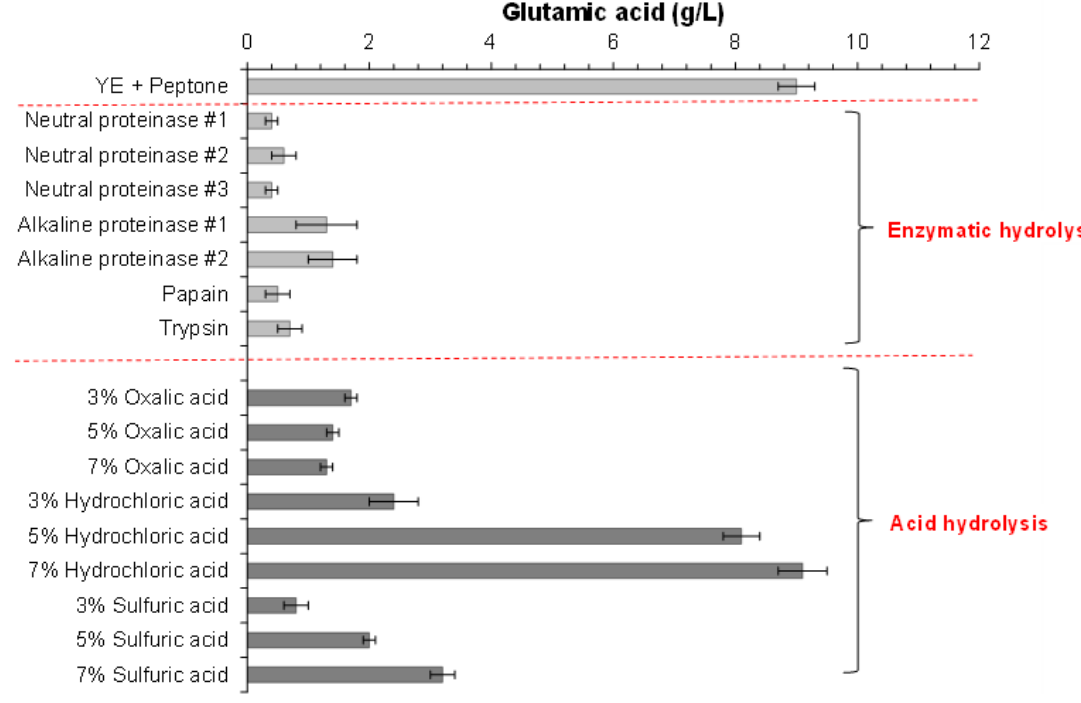
Figure 1. Cellulosic L-lactic acid fermentation performance from wheat straw using cottonseed meal hydrolysate as a complex nutrient source in flasks. The cottonseed meal was hydrolyzed by protease or acid. ( a ) Lactic acid titer; ( b ) CFU; ( c ) glutamic acid concentration in hydrolysate. The number of CFUs was measured at 24 h. Conditions: 25% ( w / w )-solids loading: 42 °C, 100 rpm, 72 h. The fermentation pH was controlled by adding 40 g/L of CaCO 3 powder. Other fermentation nutrients included 2 g/L of diammonium hydrogen citrate and 0.25 g/L of manganous sulfate monohydrate.